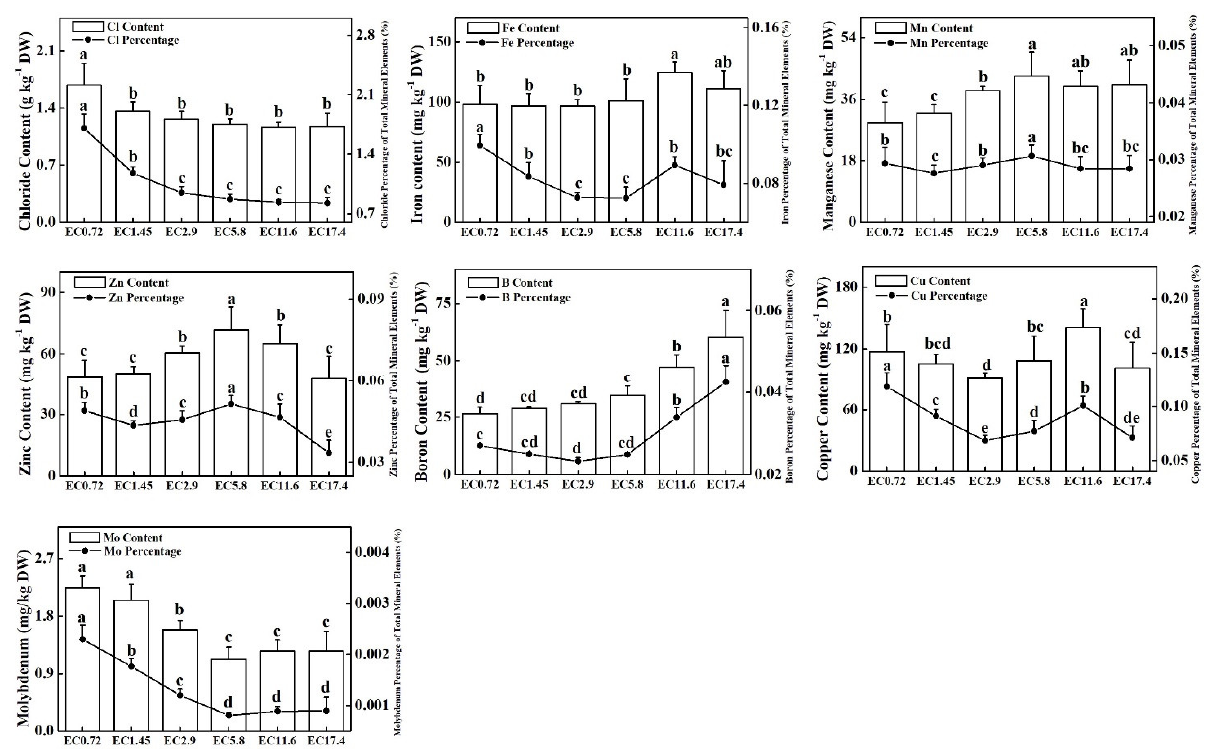
Figure 7. Effects of different EC treatments on the contents of micro plant mineral elements (PME) and their percentage of total PME after 25 days of treatment. EC0.72, EC1.45, EC2.9, EC5.8, EC11.6, and EC17.4 represent the different nutrient solution electrical conductivities of 0.72 dS m −1 , 1.45 dS m −1 , 2.9 dS m −1 , 5.8 dS m −1 , 11.6 dS m −1 , and 17.4 dS m −1 . Data represent the mean ± SD ( n = 3). Differ- ent letters indicate significant differences at α = 0.05 based on the Least Significant Difference test.